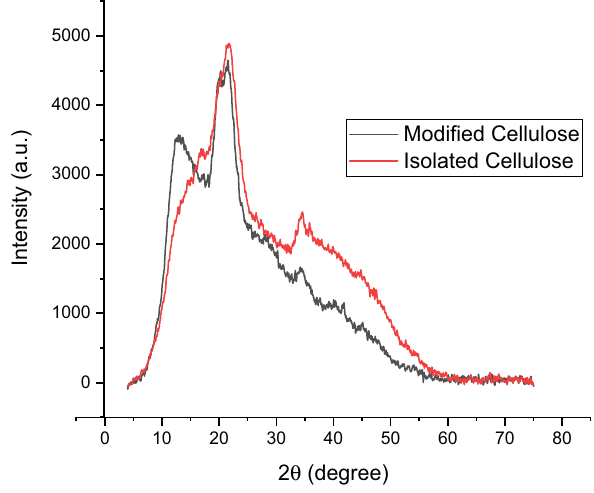
Figure 5. XRD of isolated cellulose (red) and modified cellulose (black) respectively.